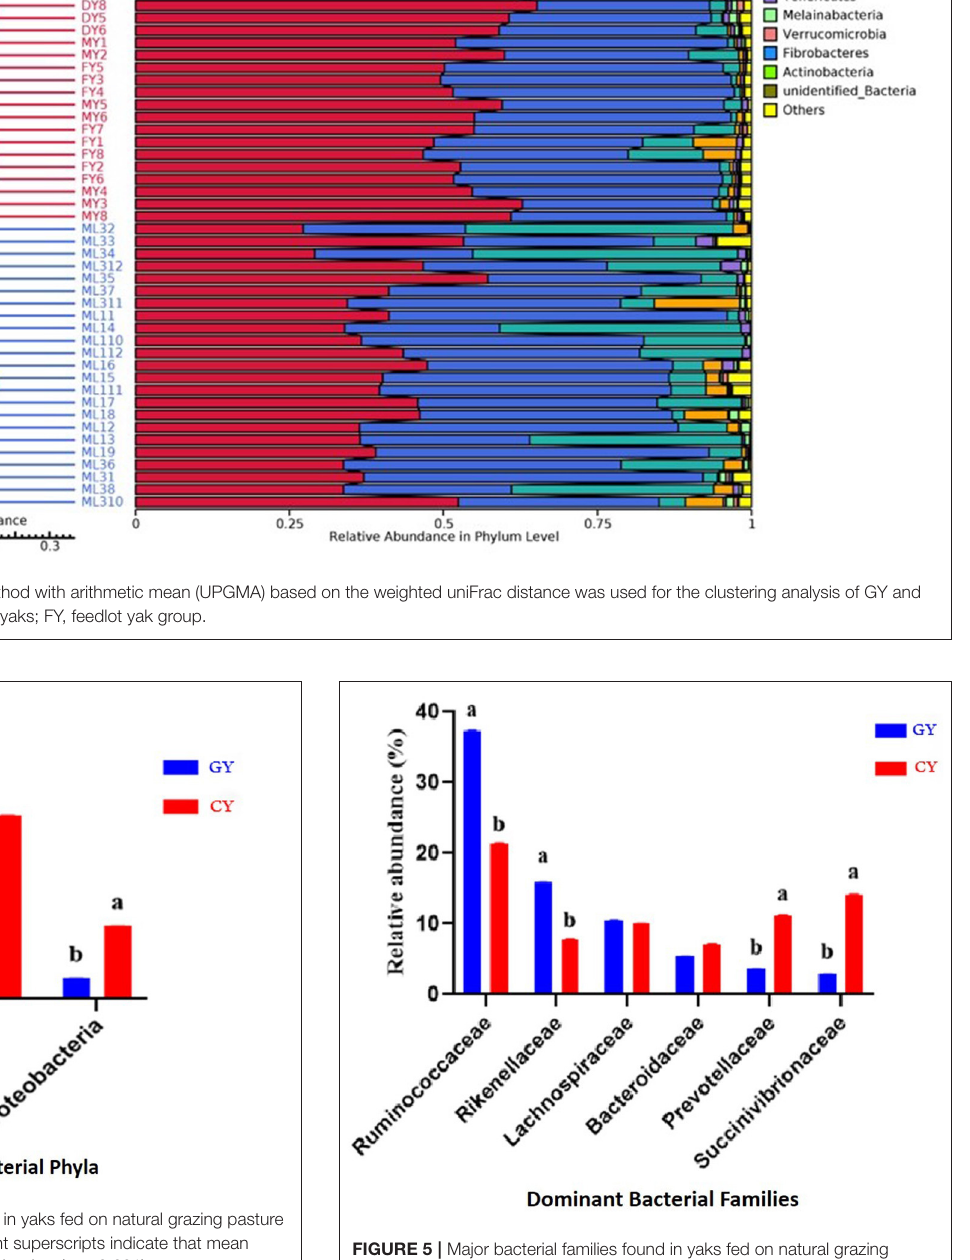
FIGURE 5 | Major bacterial families found in yaks fed on natural grazing pasture (GY) and feedlots (FY). Bars with different superscripts indicate that mean values were significantly different from each other ( p <